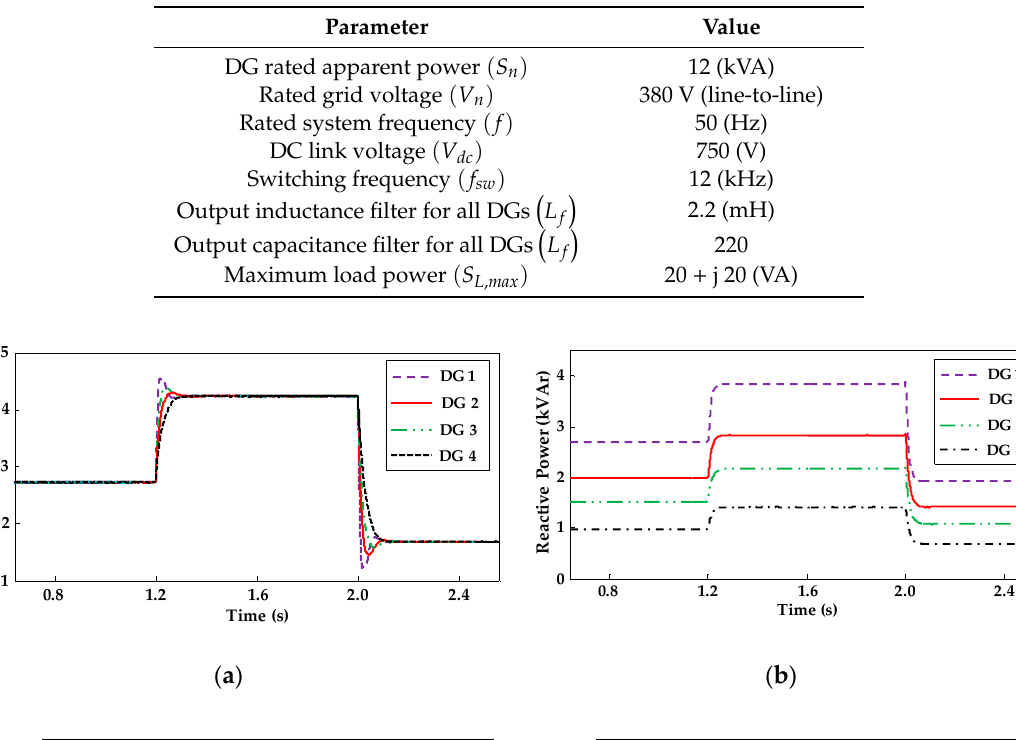
Table 3. Simulated MG electrical specifications.